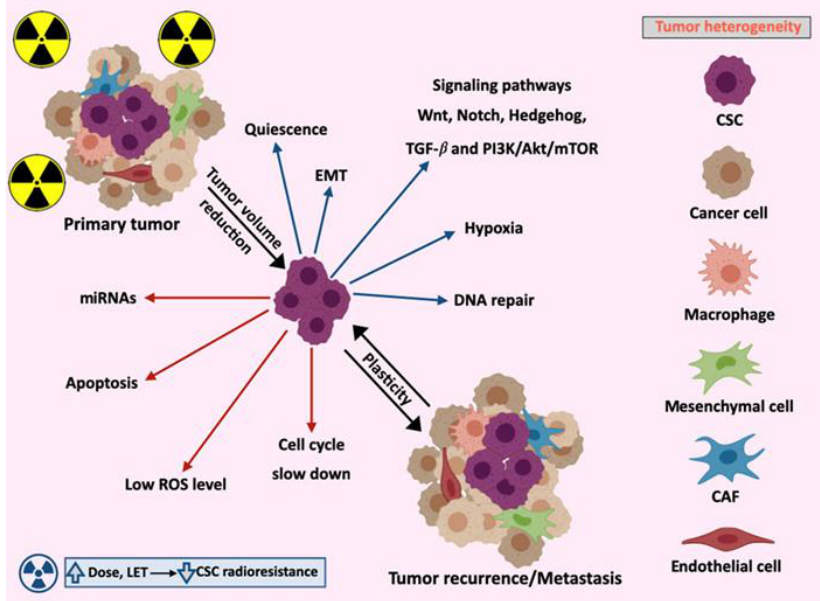
Figure 1. Targeting cancer stem cells to overcome radioresistance. Tumor heterogeneity leads to differing responses to anticancer therapies of the cell subpopulations within a tumor. Conventional